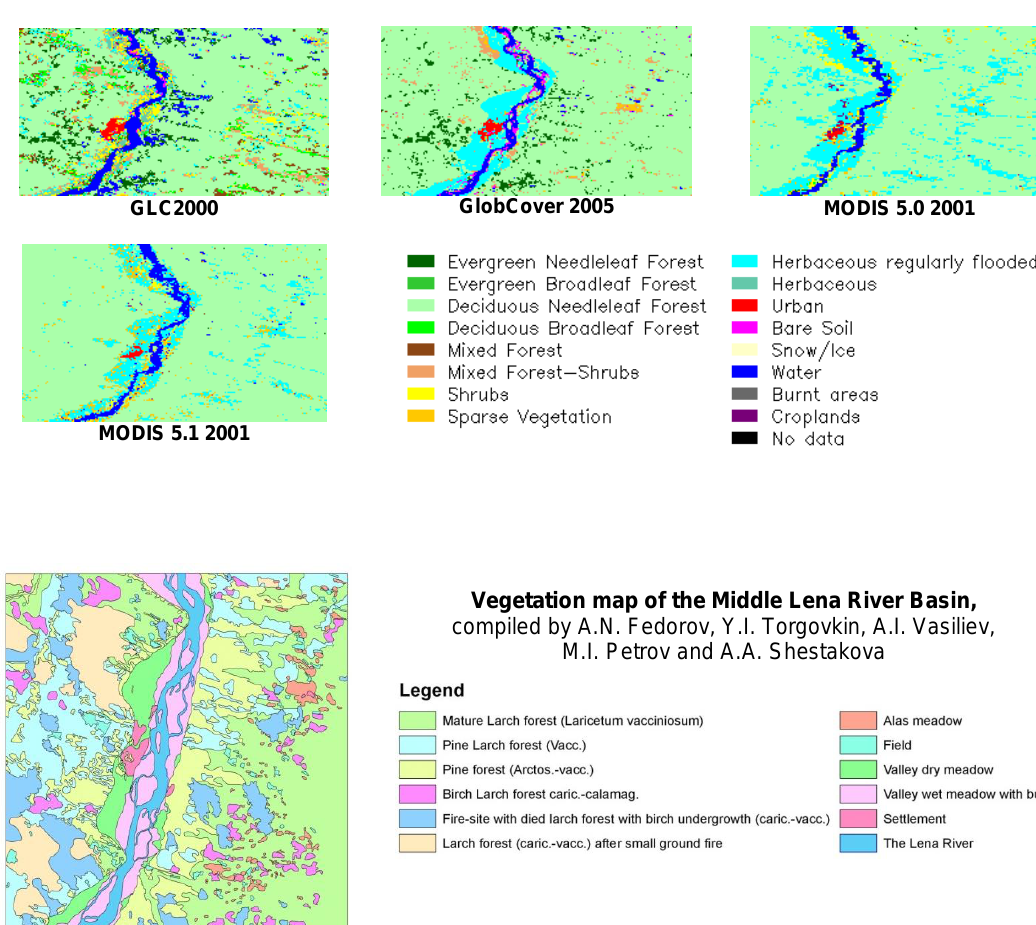
Figure 2. Comparison of five land cover products in Yakutsk region: GLC2000, GlobCover 2005, MODIS 5.0 and 5.1 for 2001, aggre- gated at 1km scale to a common legend with the land cover map provided by A. Fedorov (Melnikov Permafrost Institute, Russia, personal communication,